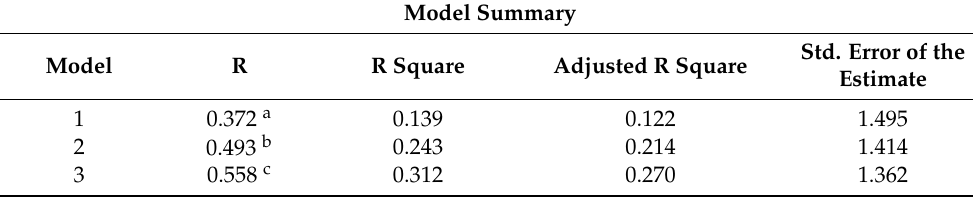
Table 3. Model summary of the predictors.